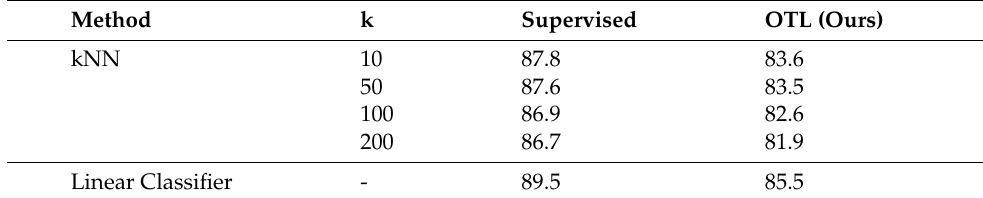
Table 10. AID: a benchmark dataset for performance evaluation of aerial scene classification.